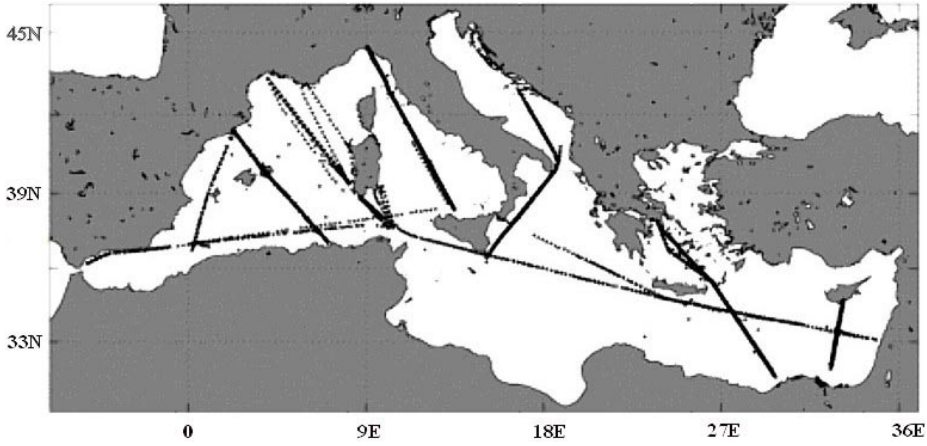
Fig. 1. The approximate position of the VOS seven tracks program in